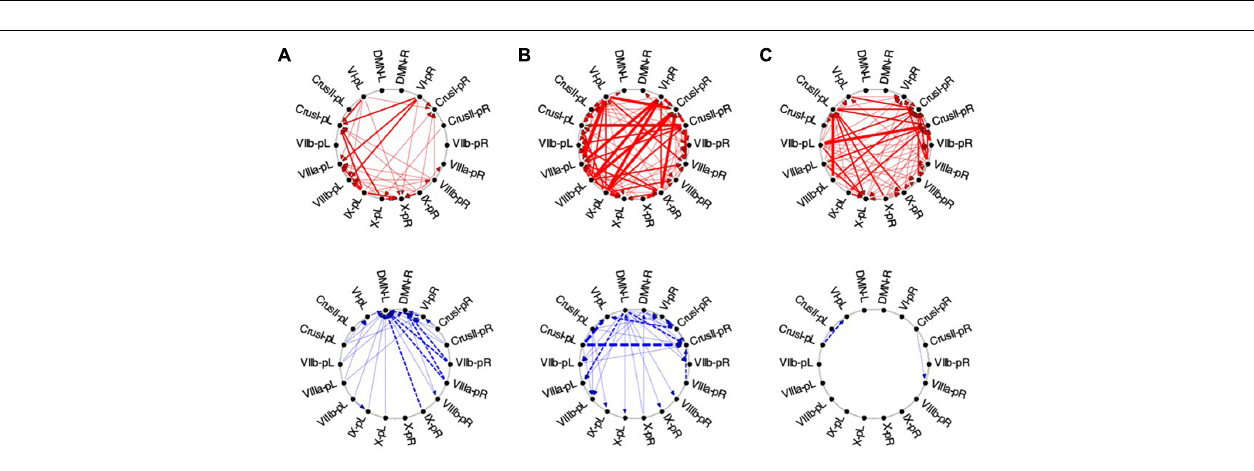
FIGURE 11 | Average Granger Causal connectivity for the perceptual exploration and Memorization ( EM ) task in the task-positive network; shown with the same format and significance criteria as for Figure 10 . The connectivity patterns had some general similarities to that for the Vis task in Figure 10 , but also major differences, in that the dominant inverse connectivity flowed from the DMN to these ROIs in the second